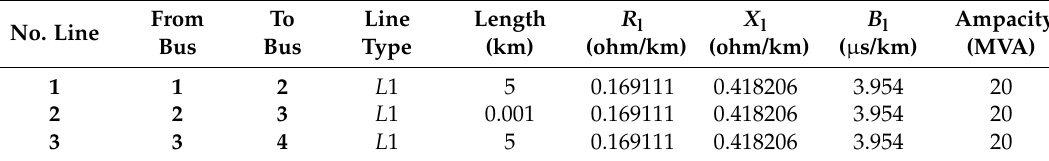
Table A1. Data of the ilustrative 4-bus network shown in Figure A1.